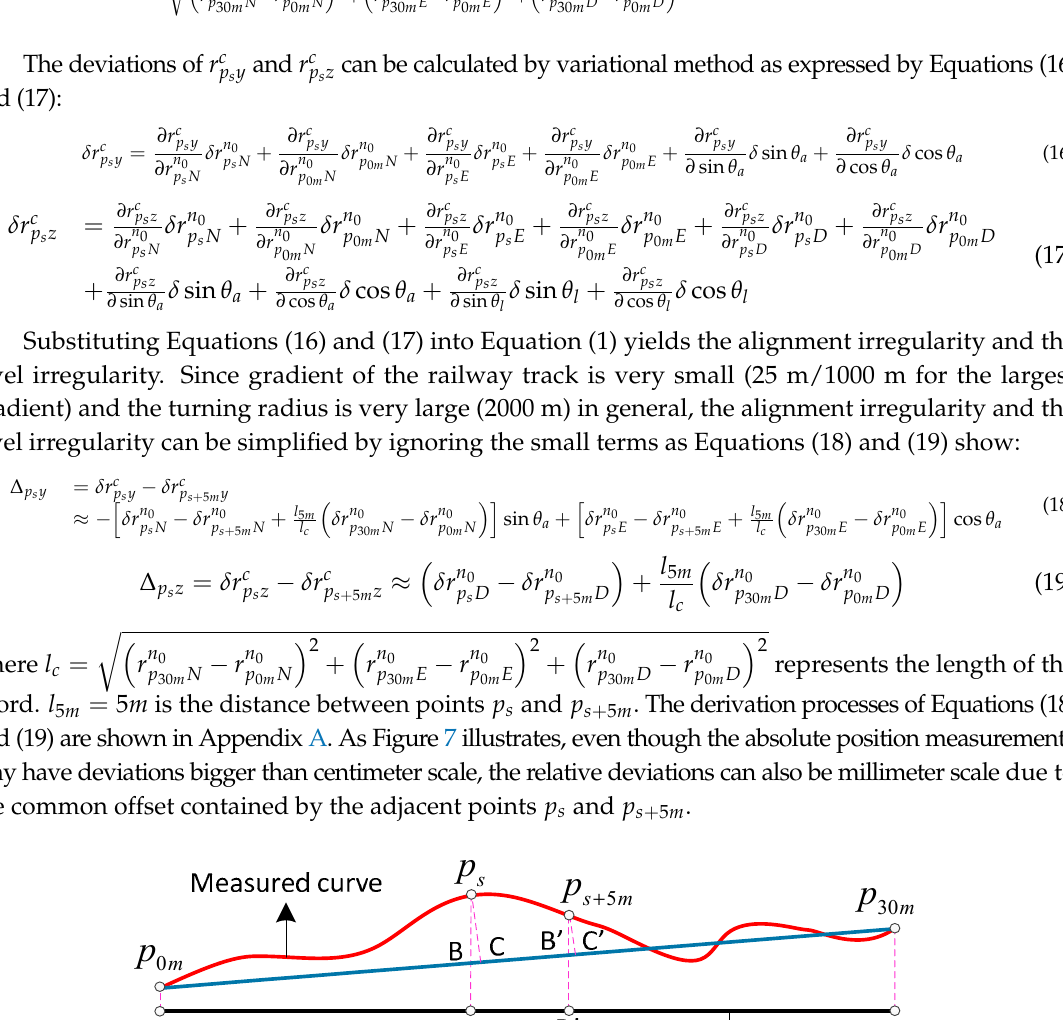
Figure 7. The relationship between absolute deviation and relative deviation.